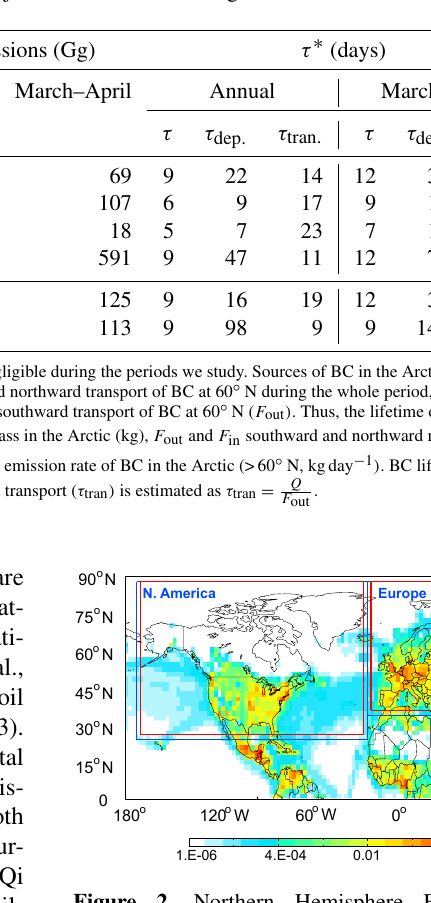
Table 1. Atmospheric lifetimes ( τ) of Arctic BC (2008) from major sources and source regions and BC emissions in these regions.